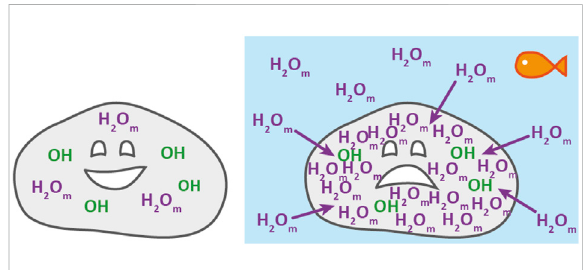
FIGURE 1 Cartoon illustrating the secondary hydration process. When fi rst erupted and deposited, glassy tephra or lava has matrix glass with dissolved H 2 O m and OH concentrations in equilibrium with the temperature of the glass transition. Following deposition, water from the surrounding environment (e.g., seawater) slowly diffuses into theglass asH 2 O m . Nospecies interconversion occurs atlowtemperaturessothisaddedH 2 O m remainsasH 2 O m ,causing increased H 2 O t and disequilibrium H 2 O speciation. However, the OH concentration remains unaltered since the glass cooled throughtheglasstransition.OH contents cantherefore beusedto investigate primary degassing processes related to eruption and